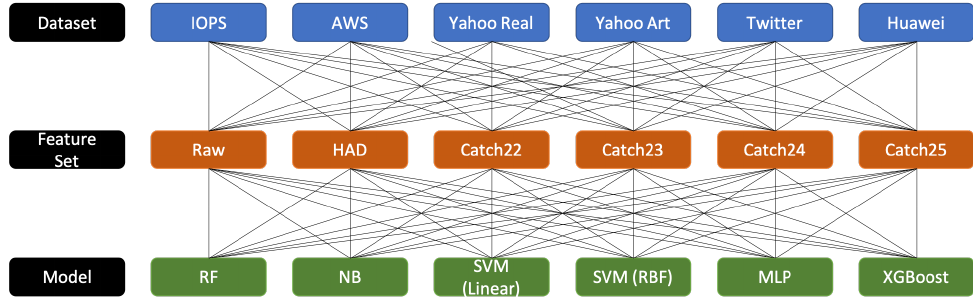
Figure 1. The combinations of datasets, feature sets, and models used in the experiments. Non- standard terminology and acronyms: catch23 is catch22+sr, catch24 is catch22+mean+variance, catch25 is catch22+sr+mean+variance, random forest (RF), Naïve Bayes (NB), multi-layer perceptron (MLP), radial basis function (RBF), and multilayer perceptron (MLP).